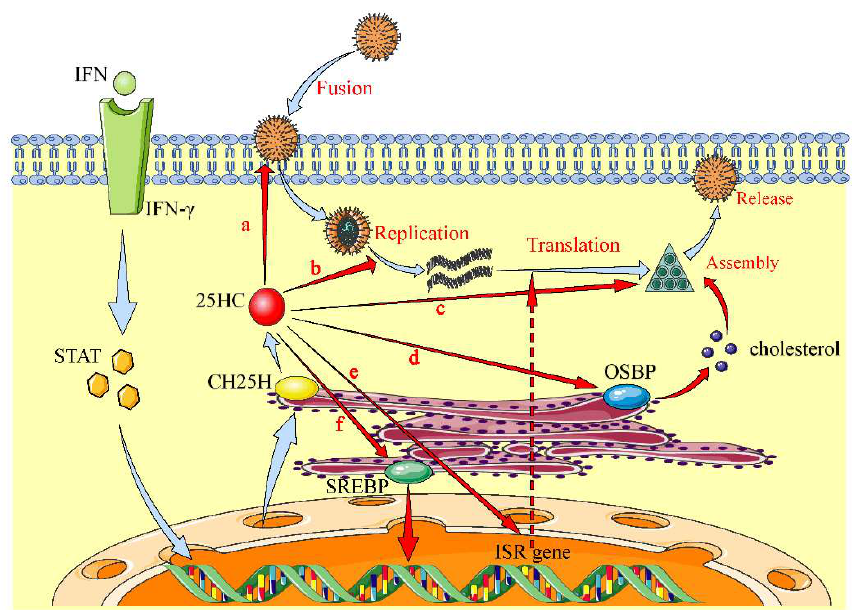
Figure 3. Broadly antiviral activities of 25HC through multiple mechanisms. The expression of CH25H can be induced through interferon receptor (IFNR) signaling, and then the production of 25HC is promoted from converting cholesterol. Studies have showed that CH25H and 25HC are involved in broadly antiviral activity via various mechanisms, including a, Inhibition of virus adsorption and entry by decreasing the cholesterol level of plasma membrane lipids; b, Inhibition of viral genome replication; c, Antagonizing prenylation of viral and endogenous protein that is involved in viral replication and assembly; d, Interactions with oxysterol-binding proteins to alter the cholesterol distribution; e, Activation of the gene expression associated with the integrated stress response (ISR) in macrophages, increasing oxidative stress and translation suppression; and f, Regulation of inflammation, innate immunity, and adaptive